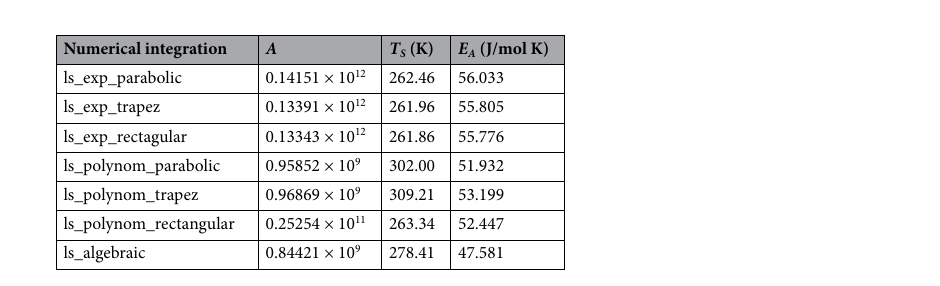
Table 3. Numerical values of kinetic parameters determined using various integration methods for β = 20, δ_random_T’ = 0.1, N polynom = 7.